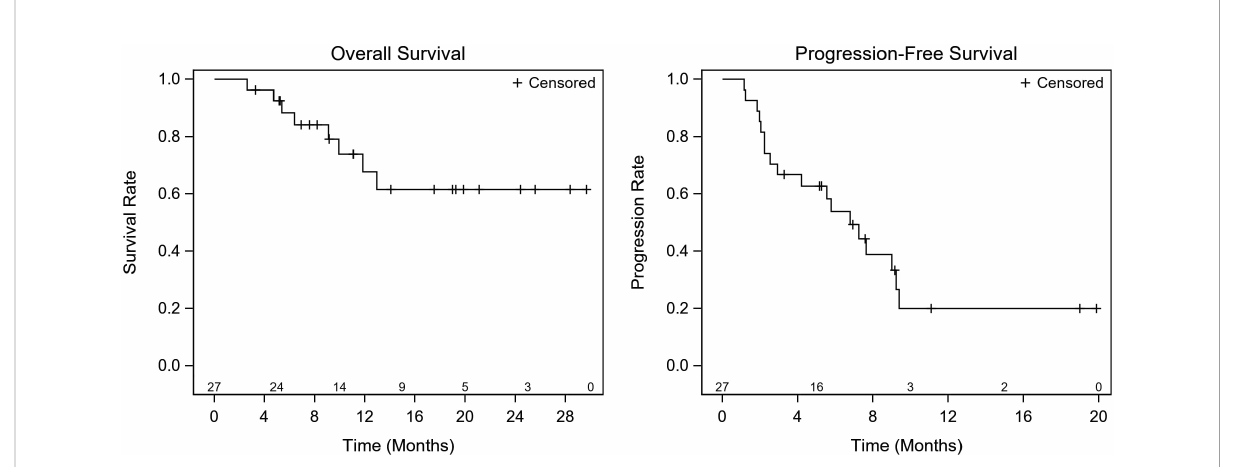
FIGURE 2 RDI & Survival Summary. There was no statistically signi fi cant difference in RDI in terms of the OS or